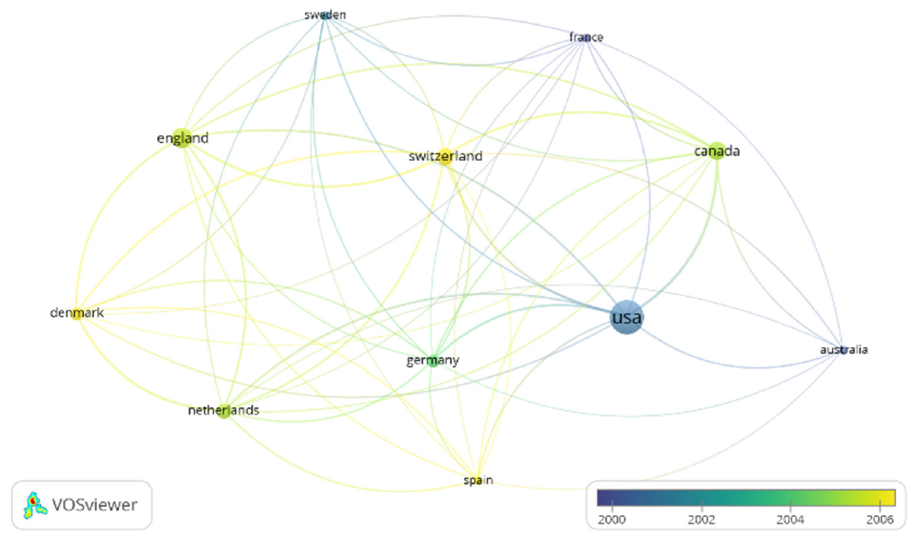
Figure 5. The country collaboration network.